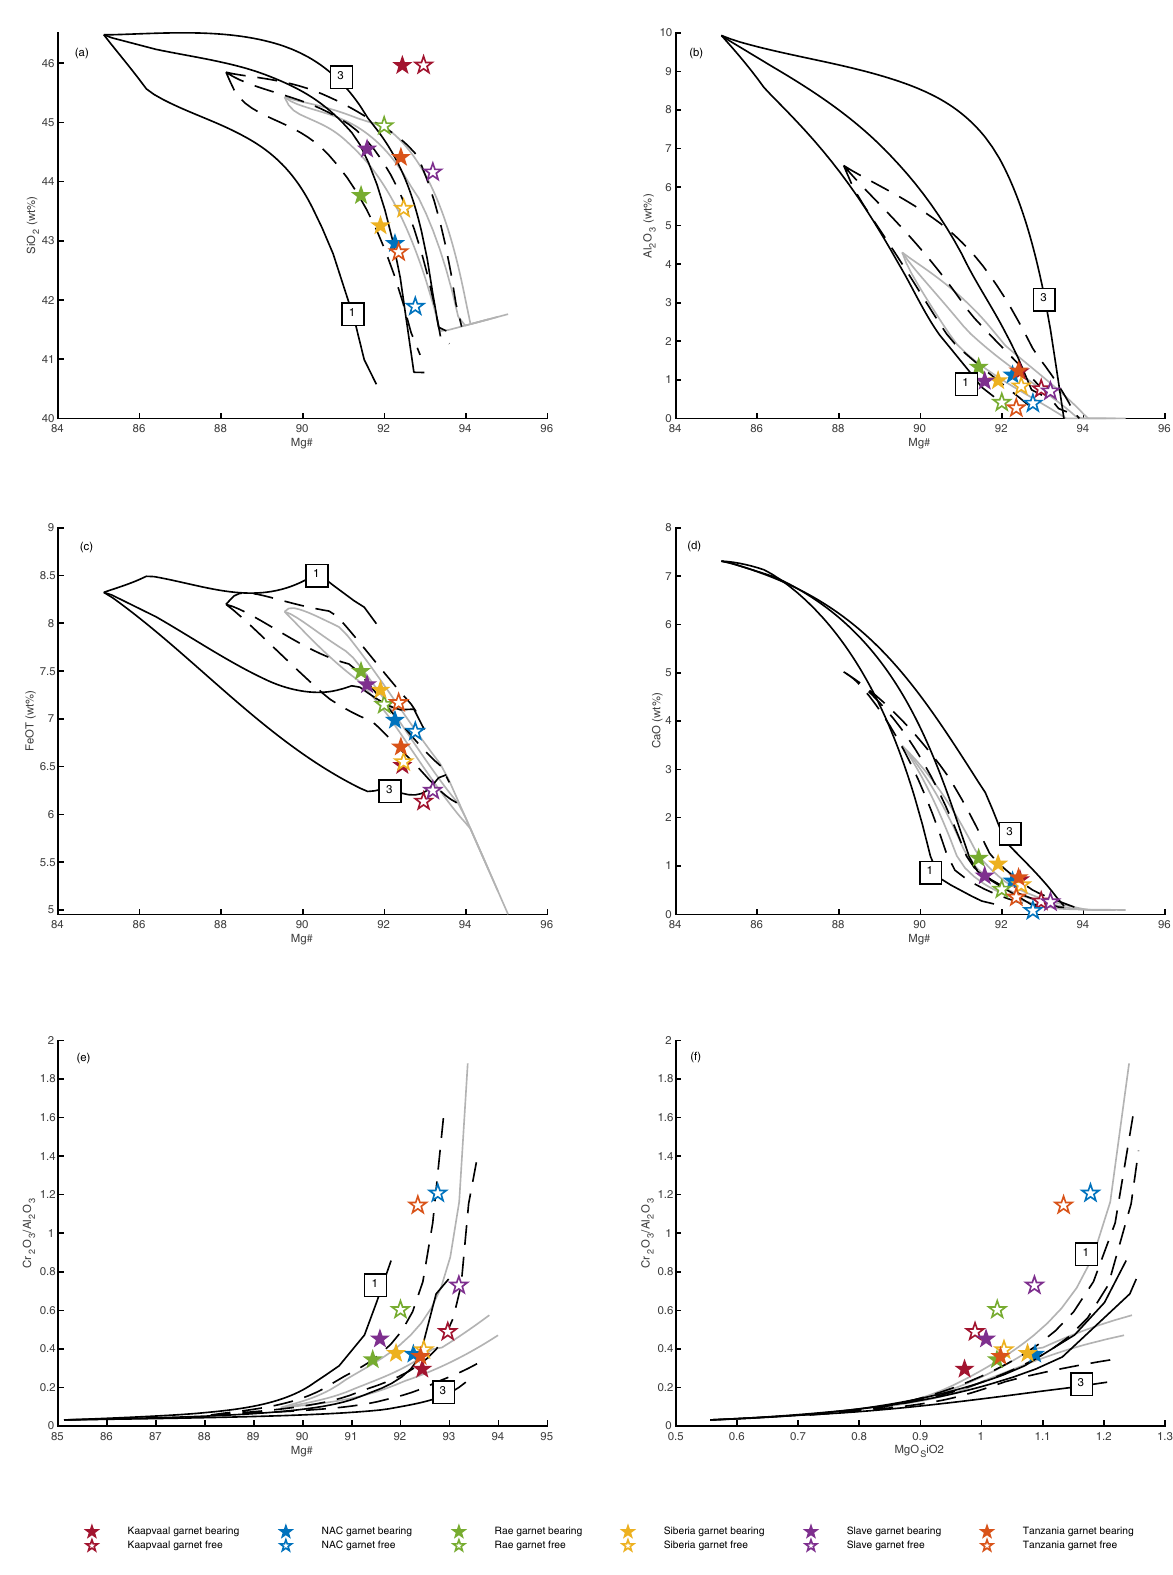
Fig. 5 Modelled compositions residues after melting of basalt-peridotite hybrid rocks. Starting compositions composed of 20% basalt and 80% fertile peridotite (black dashed lines) and 50% basalt and 50% fertile peridotite (black solid lines) compared to residues after melting of fertile peridotite (grey lines) from fi gure 3. ( a ) Mg# - SiO 2 , ( b ) Mg# - Al 2 O 3 , ( c ) Mg# - FeO, ( d ) Mg# - CaO, ( e ) Mg# - Cr 2 O 3 /Al 2 O 3 , ( f ) MgO/SiO 2 - Cr 2 O 3 /Al 2 O 3 . Low and high pressure is labelled in GPa. Median compositions of garnet bearing (solid symbols) and garnet free (open symbols) cratonic peridotites were calculated from the literature